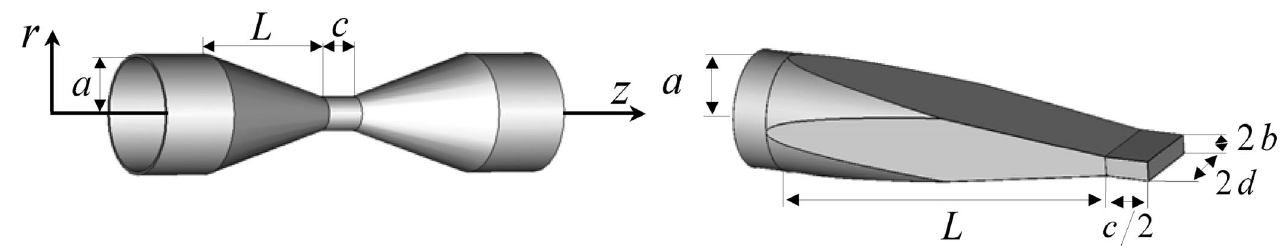
FIG. 5. The geometry of round and rectangular collimators.